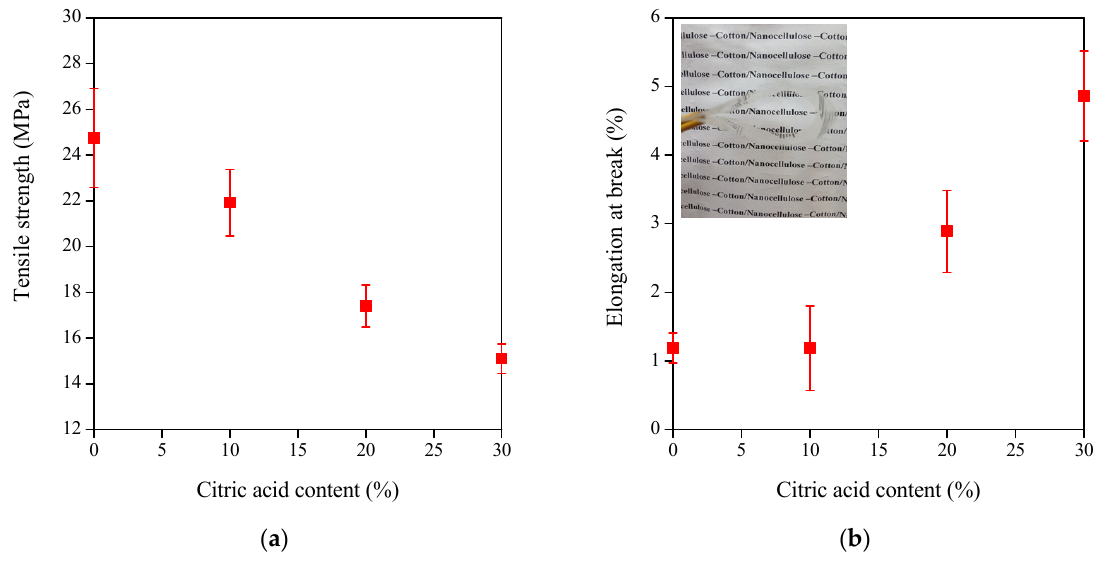
Figure 6. Tensile strength ( a ) and elongation at break ( b ) of CNC-CA films plasticized with 15% glycerol as a function of citric acid concentration. Inset in Figure ( b ) represents the photo of the flexible CA-30% film.